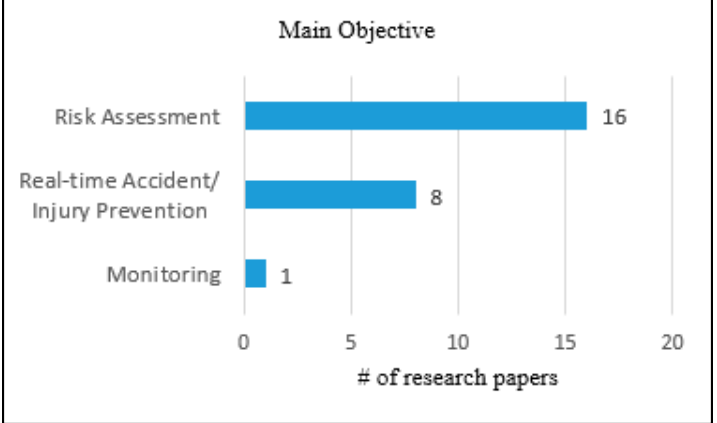
Figure 5. Main objectives of existing applications.